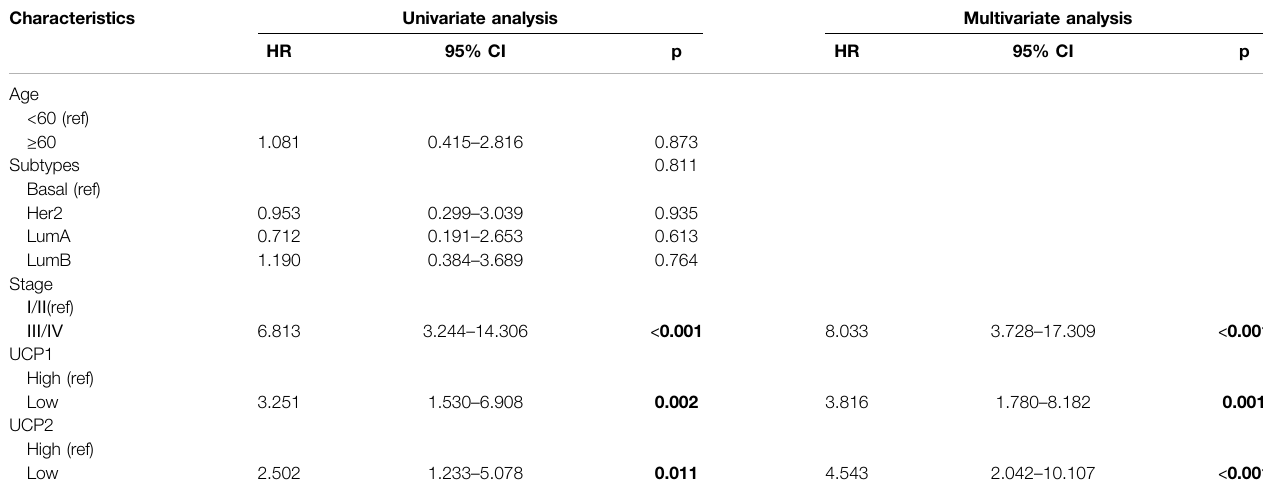
TABLE 2 | Cox regression analyses in cohort 2. Bold indicates p -values less than 0.05.